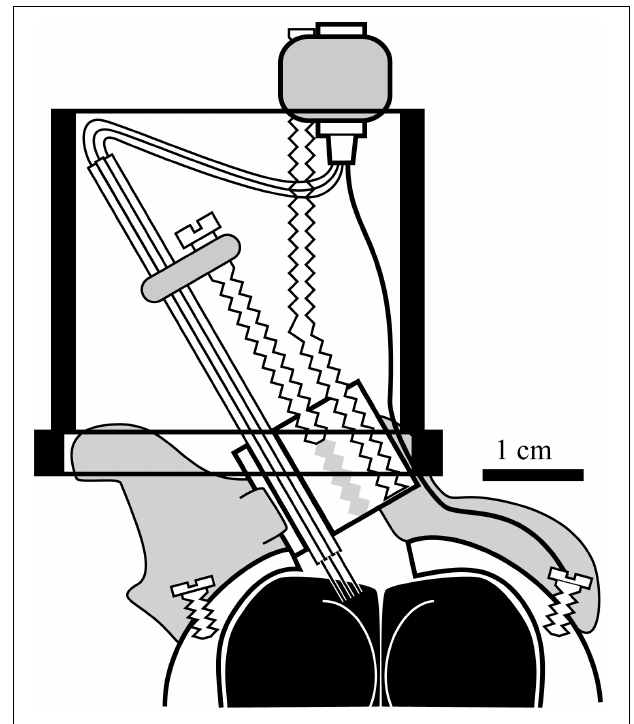
FIGURE 2 | Headstage design used in the majority of the studies involving the Bingman lab. A custom Drive screws were tapped into a Delrin block and connected to bundles of tetrode microelectrodes such that every full turn of the drive screw drove the tetrode bundles 320- µ m further into the brain. The wires were soldered into a 16-pot connector connected to the headstage via threaded rod that also had a ground connection that was secured to the brain via a separate wire. Once assembled, the headstage was secured to the skull using stainless steel screws that were covered with dental cement (gray shading), which also protected the small area of exposed brain. In two studies (Hough and Bingman, 2004, 2008), the drive was implanted at a 30-degree angle as pictured, to maximize coverage of the medial HF (dotted lines indicate representative tetrode trajectories) without damaging the central sinus on the surface of the brain (gray stippled oval in Figure 1B ). The drive was mounted inside an inverted 35-mm film canister lid, so that the delicate tetrode connections would be protected by the rest of the canister (black outline) during and between experimental trials. Further details can be found in Siegel et al. (2002) and Hough and Bingman